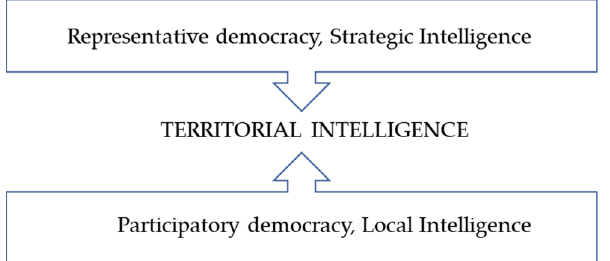
Figure 2. Territorial Intelligence at the heart of a “top–bottom” dialectic (Dumas 2012).